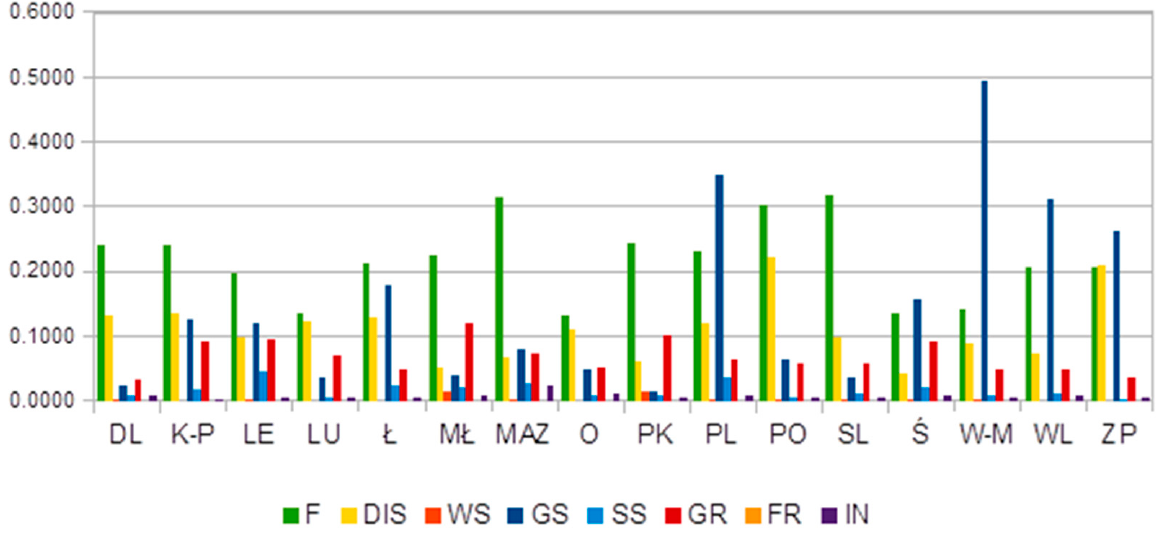
Figure 1. Within-voivodeship inequality. Source: Authors’ Figure 1. Within ‐ voivodeship inequality. Source: Authors’ calculations.